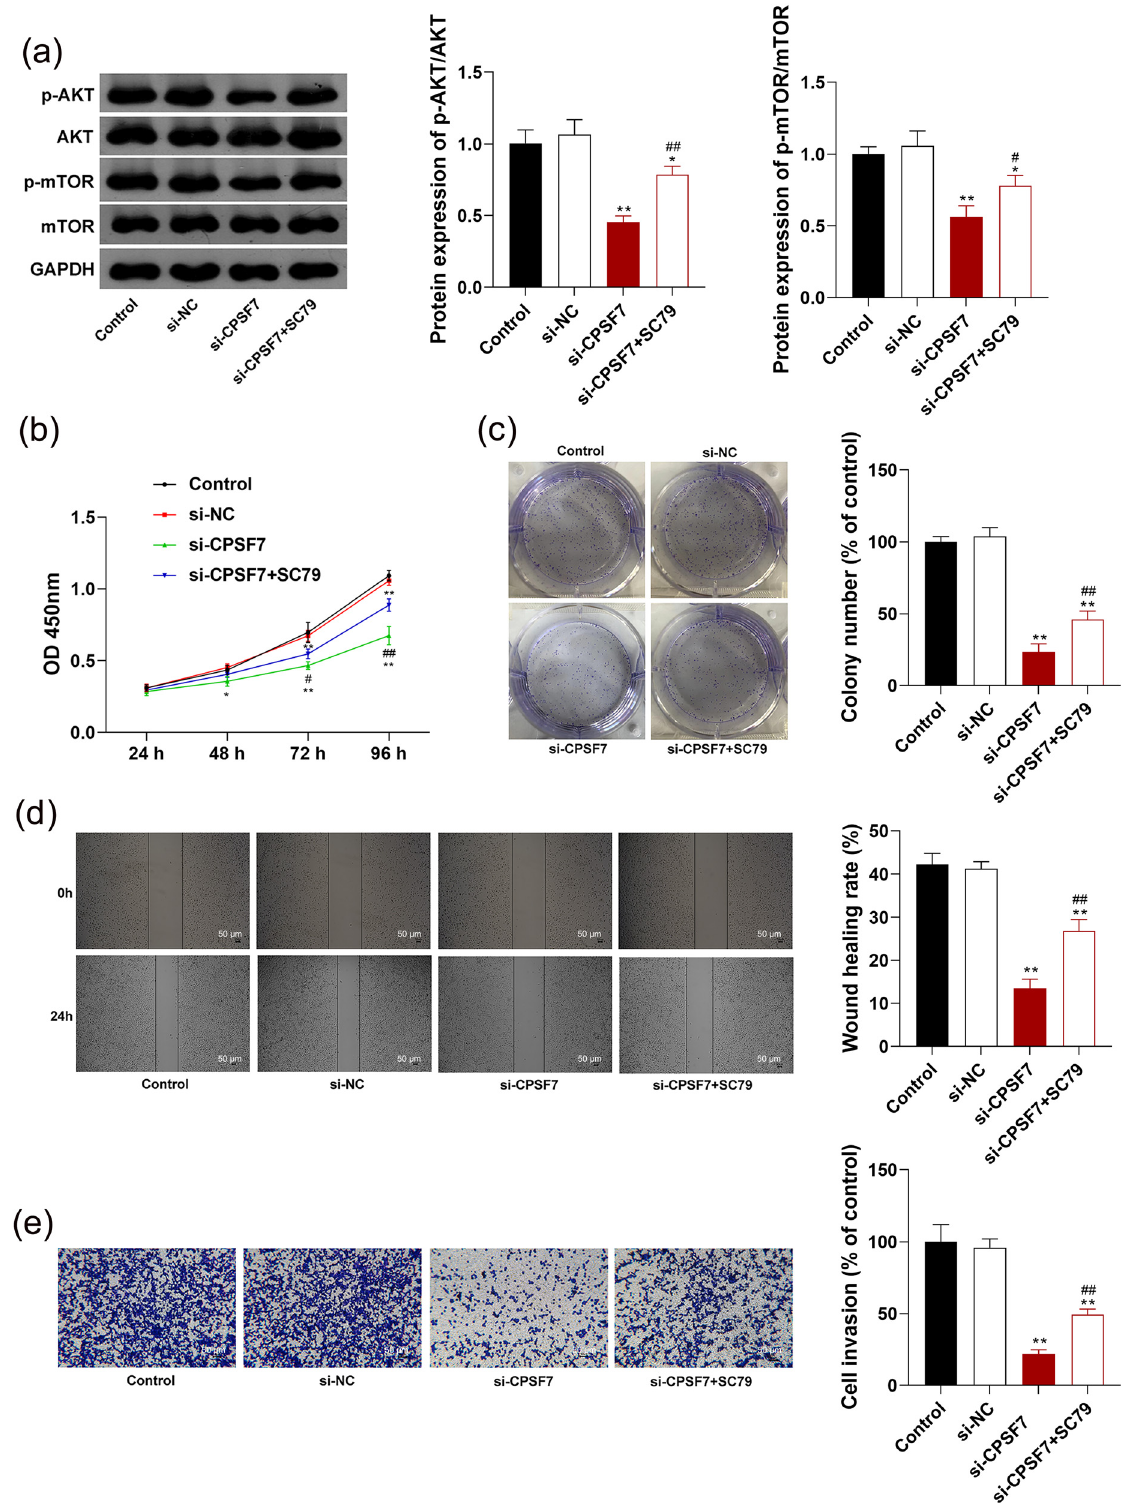
Figure 4: Silencing of CPSF7 inhibits the malignant characteristics of LUAD cells by blocking the AKT/mTOR signaling pathway. ( a ) Protein expression of p - AKT/AKT and p - mTOR/mTOR was detected by Western blotting. ( b ) Cell viability was measured by CCK - 8 assay. ( c ) Colony number was detected by colony formation assay. ( d ) Cell migration rate was detected by wound healing assay ( scale bar = 50 µm ) . ( e ) Invasion rate was detected by Transwell assay ( scale bar = 50 µm ) . A549 cells were transfected with si - CPSF7 and treated with SC79 ( an activator of the AKT/mTOR pathway ) . Each experiment was repeated three times ( n = 3 ) . * P < 0.05, ** P < 0.01 vs Control; # P < 0.05; ## P < 0.01 vs si - CPSF7